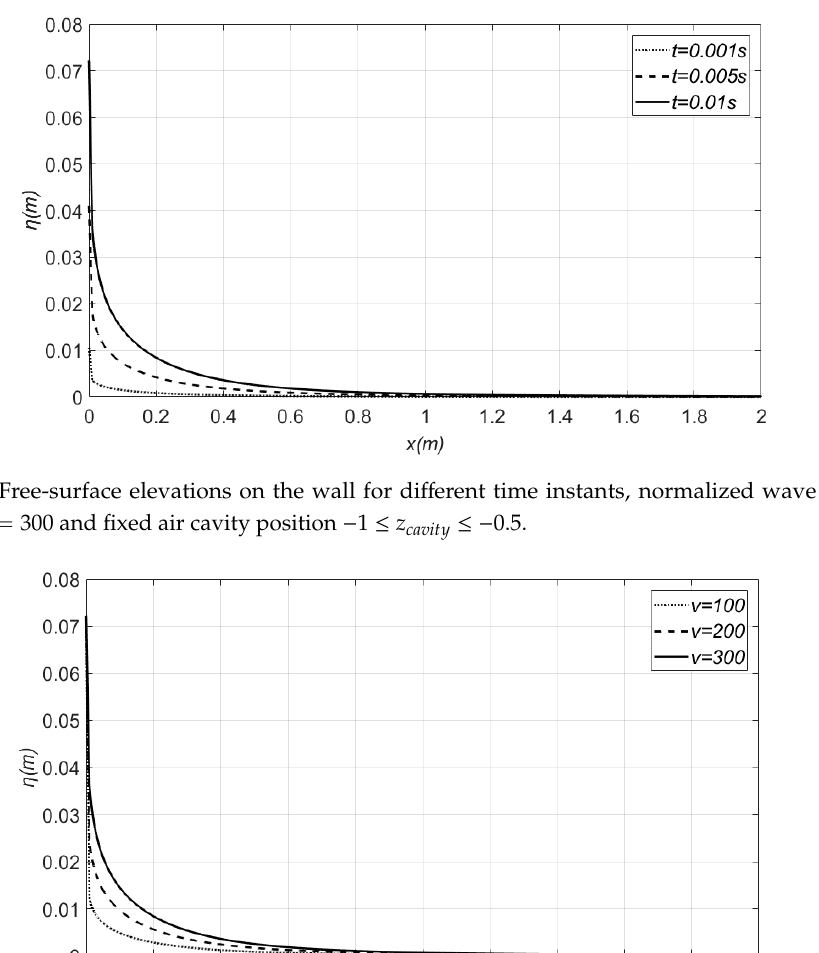
11 of 14 Figure 8. Contours of the hydrodynamic pressure in the liquid domain for fixed air cavity position −1 ≤ (cid:1878) (cid:3030)(cid:3028)(cid:3049)(cid:3036)(cid:3047)(cid:3052) ≤ −0.6 , fixed wave impact velocity (cid:1874) = 300 and (cid:1872) = 0.01(cid:1871) . Figure 9 shows that the portion of the water, which collides with the wall, in the region of the